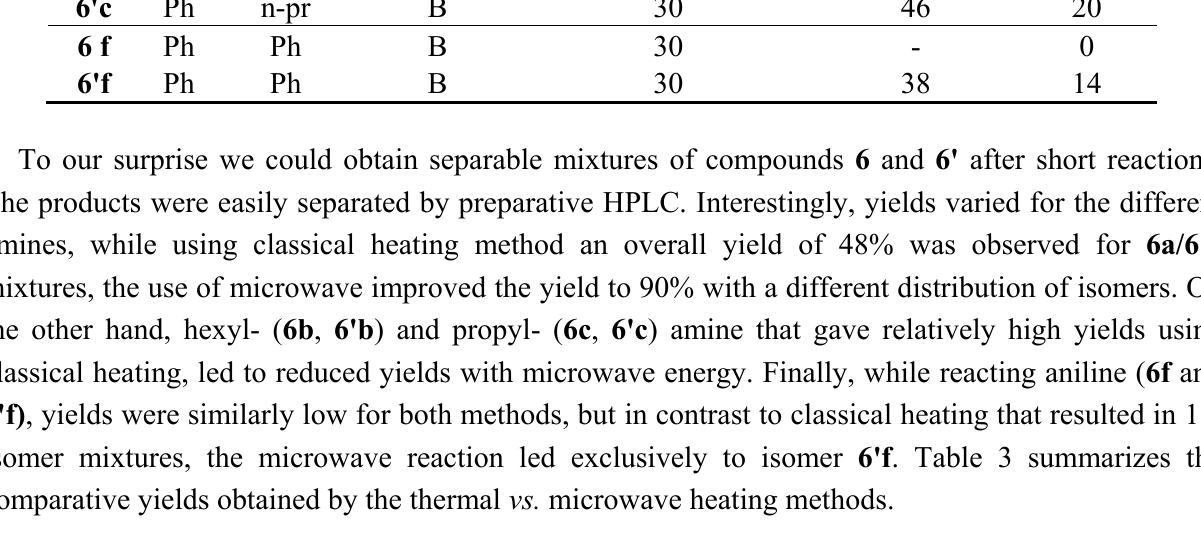
Table 3. Yields and six/five ratio of thermal vs. microwave assisted